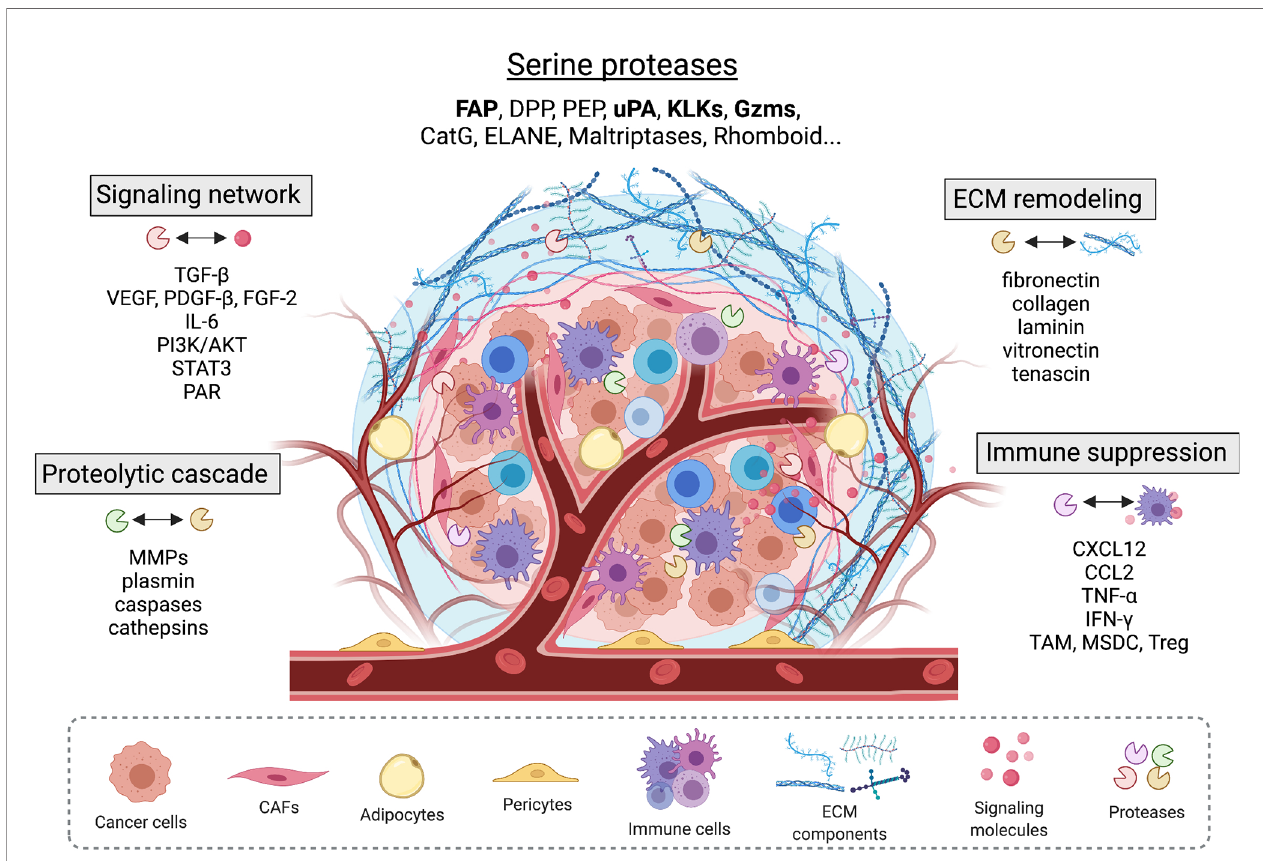
FIGURE 1 | Serine proteases found in the tumor microenvironment modulate tumor-stromal interplay by interacting with other proteases, extracellular matrix proteins, and important signaling pathways that involve growth factors, cell surface receptors, cytokines and